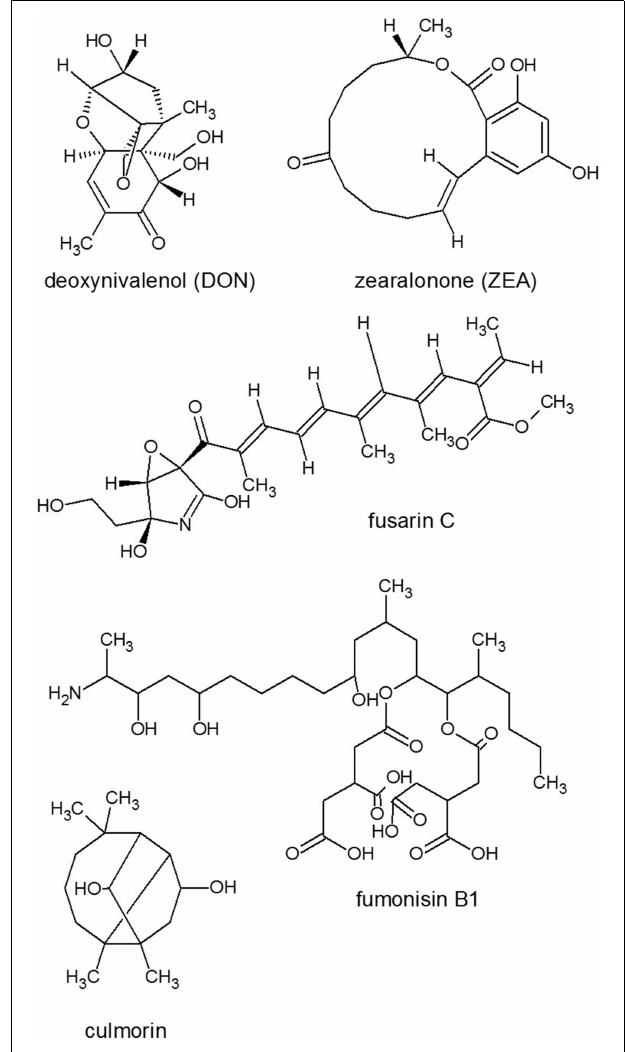
FIGURE 3 | Structures of representatives of Fusarium SMs. Source: National Center for Biotechnology Information. PubChem